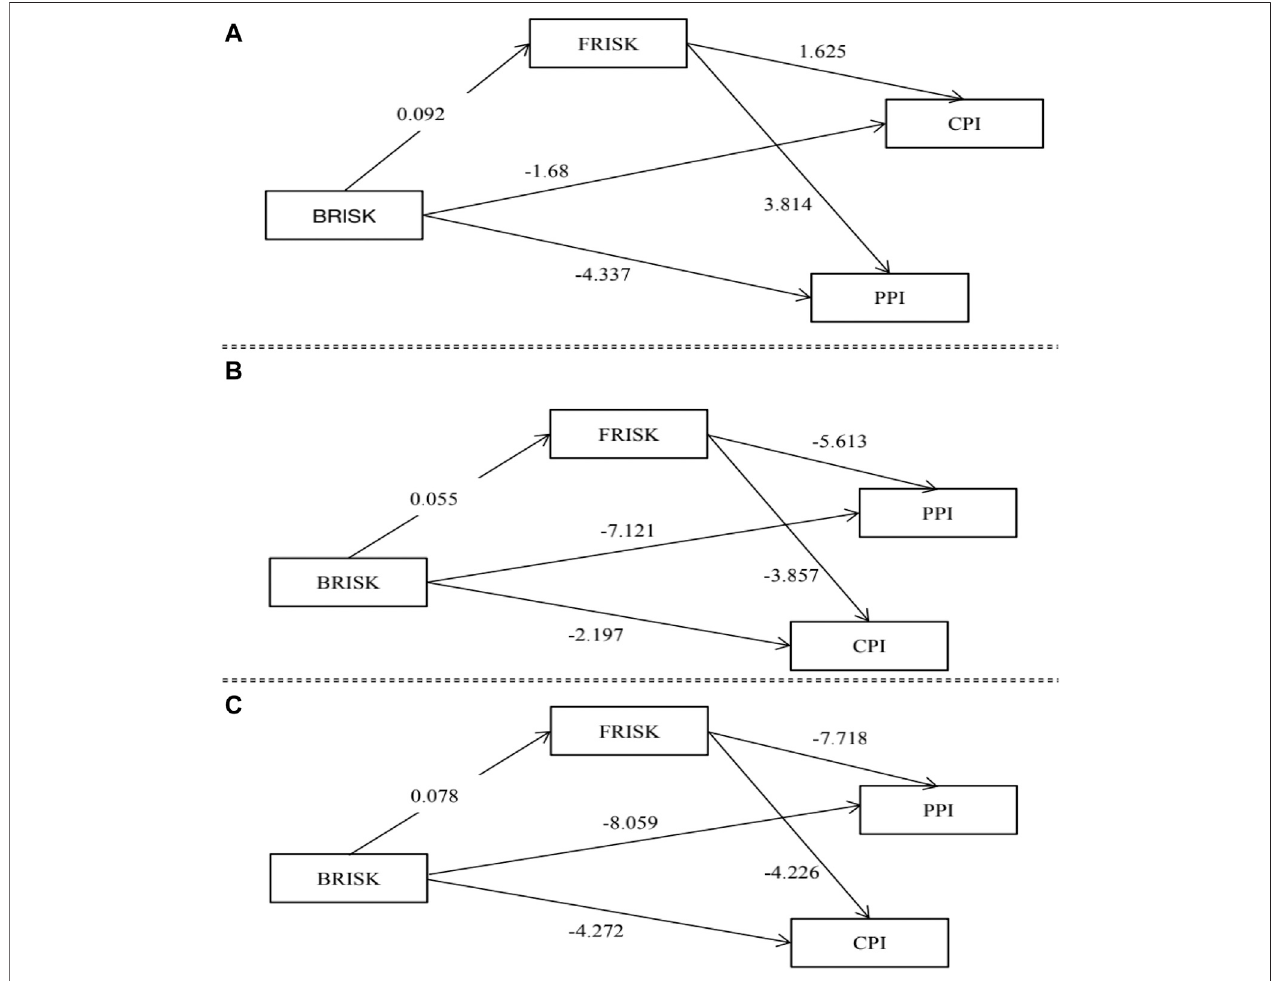
FIGURE 6 | The channel effect of fi nancial market risk under different returns trends. Note: (A,B) show the channel effect of fi nancial market risk in the impact of international crude oil market downward returns risk when oil commodity attribute and dual attribute dominate, respectively; (C) represents the channel effect of the fi nancial market risk when the dual attribute of oil dominates in the international crude oil market upward returns risk. The number on the arrow represents the impact coef fi cient.